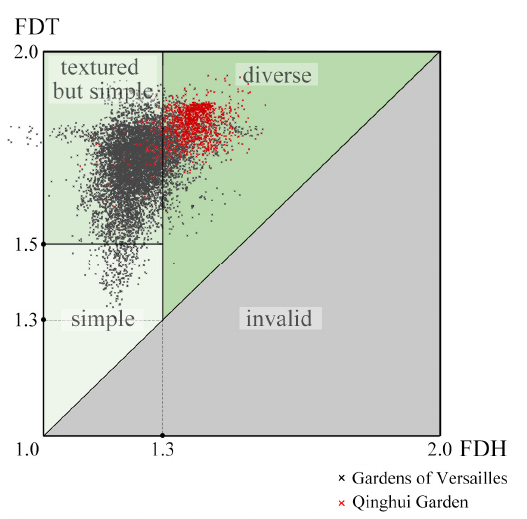
Figure 8. The classification in the FDT-FDH evaluation system, and the distributions of the two gardens in it. gardens in